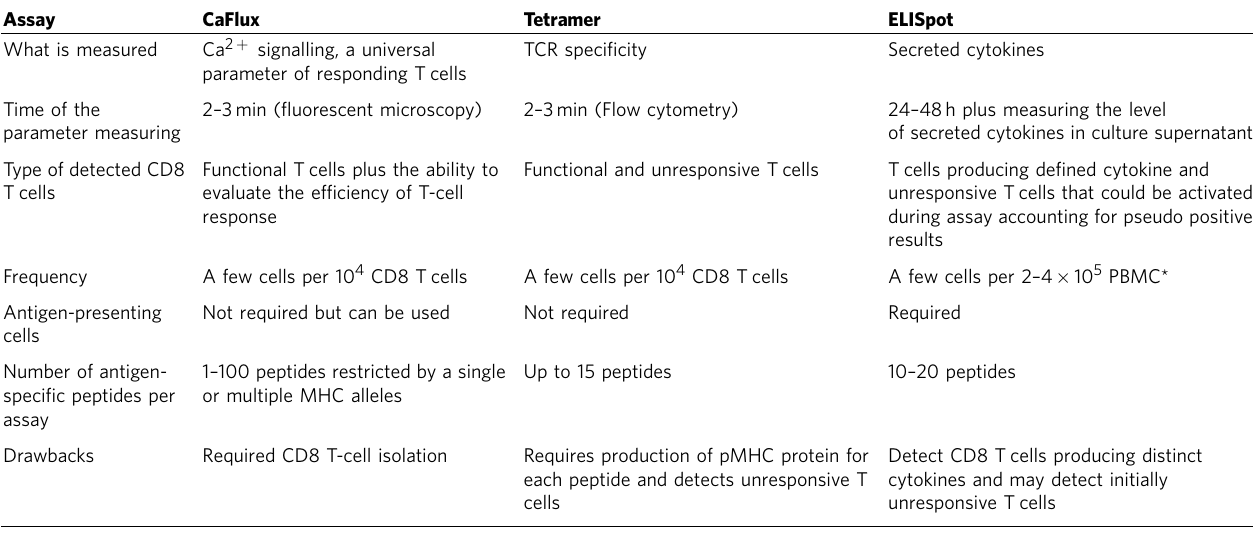
Table 1 | Comparison of CaFlux with Tetramer and ELISpot